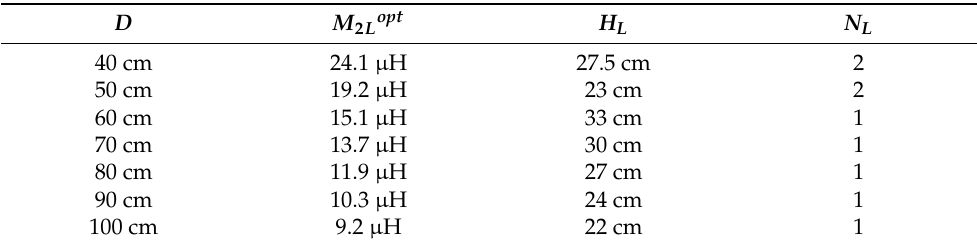
Table 2. Design parameters of the rectangular load coil for optimal load impedance matching in Figure 11.